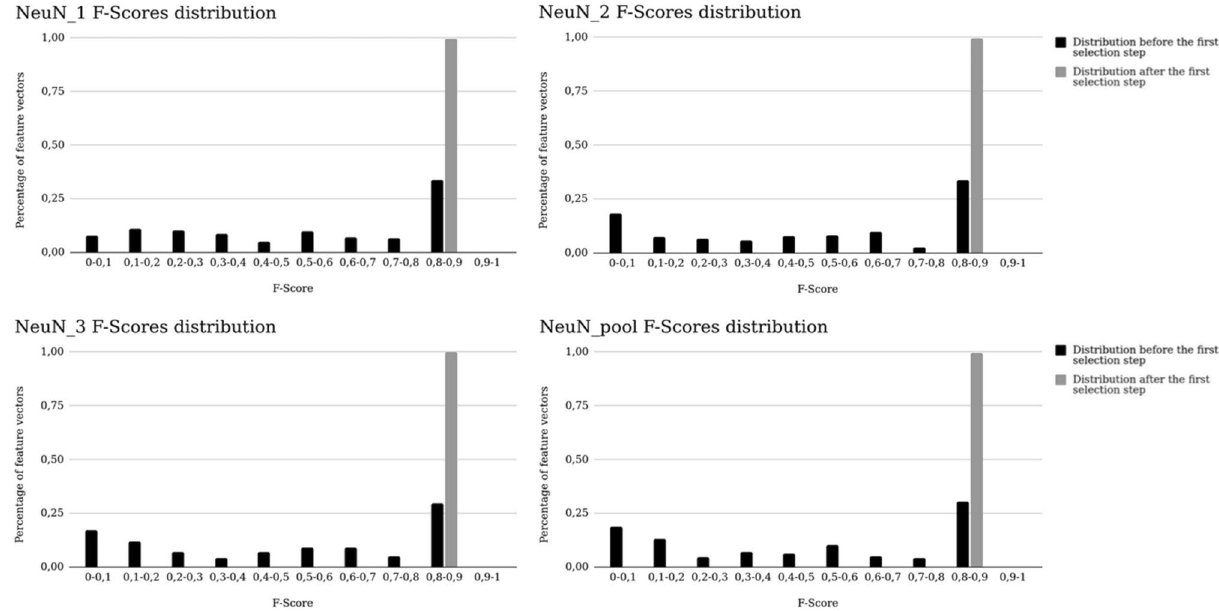
Figure 7. Evolution of the F-Score distribution among all combinations before (in black) and after (in grey) the first selection step for NeuN